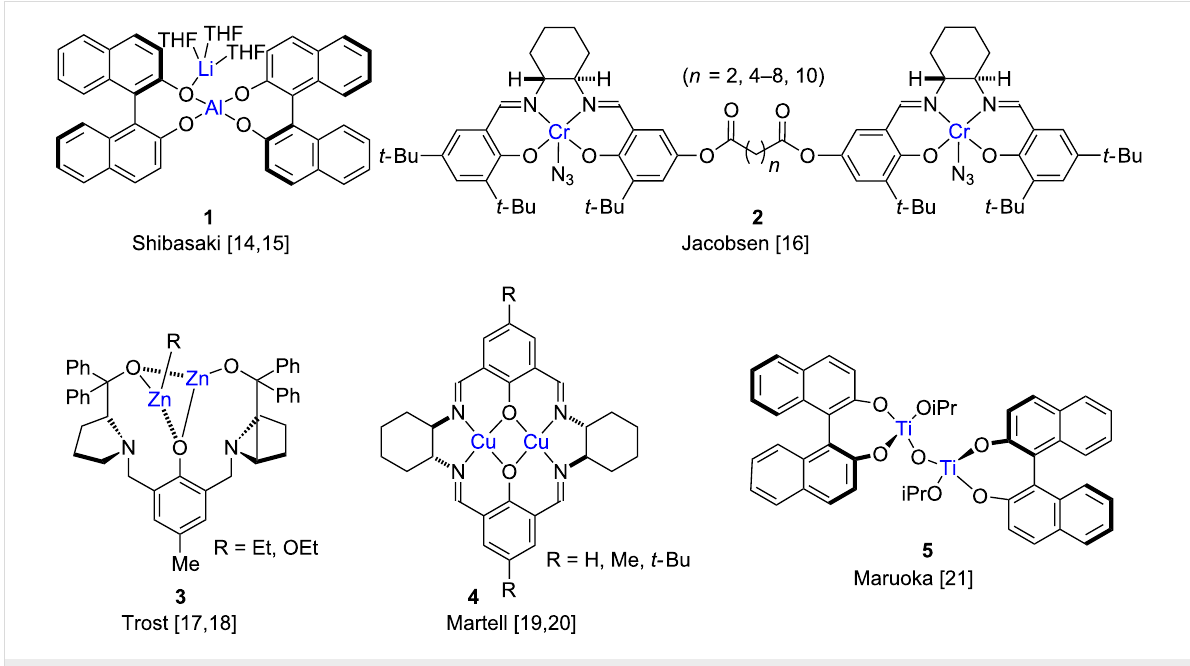
Figure 1: Examples of chiral bimetallic complexes utilized in asymmetric